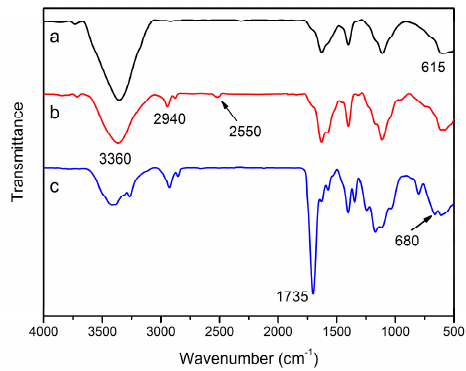
Figure 2. Fourier transform infrared (FT-IR) spectra of ( a ) raw TiO 2 , ( b ) TiO 2 -KH590 and ( c ) TiO 2 - hyperbranched polymers (HBPs).